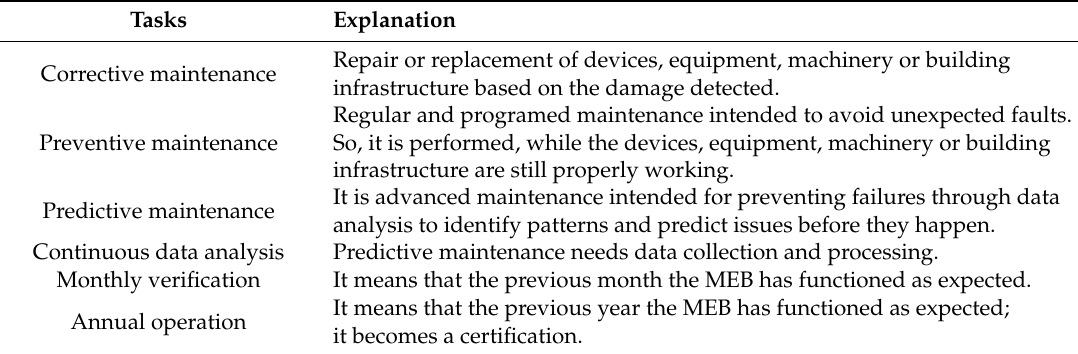
Table 5. Operations management of the refurbished building. MEB life cycle management